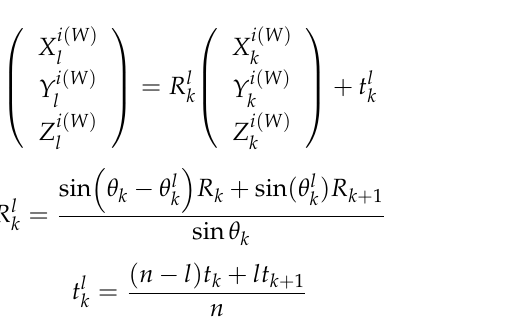
Figure 3. The 3D point cloud densification model.